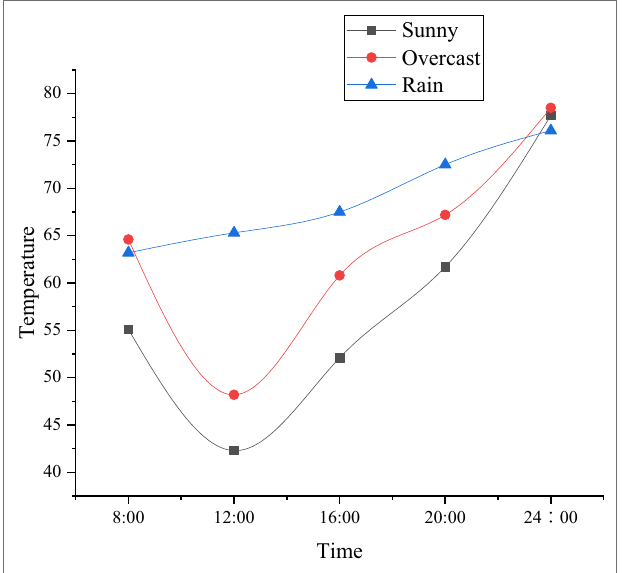
FIGURE 15 | The death of plants and seedlings under artificial planting and IoT monitoring technology.